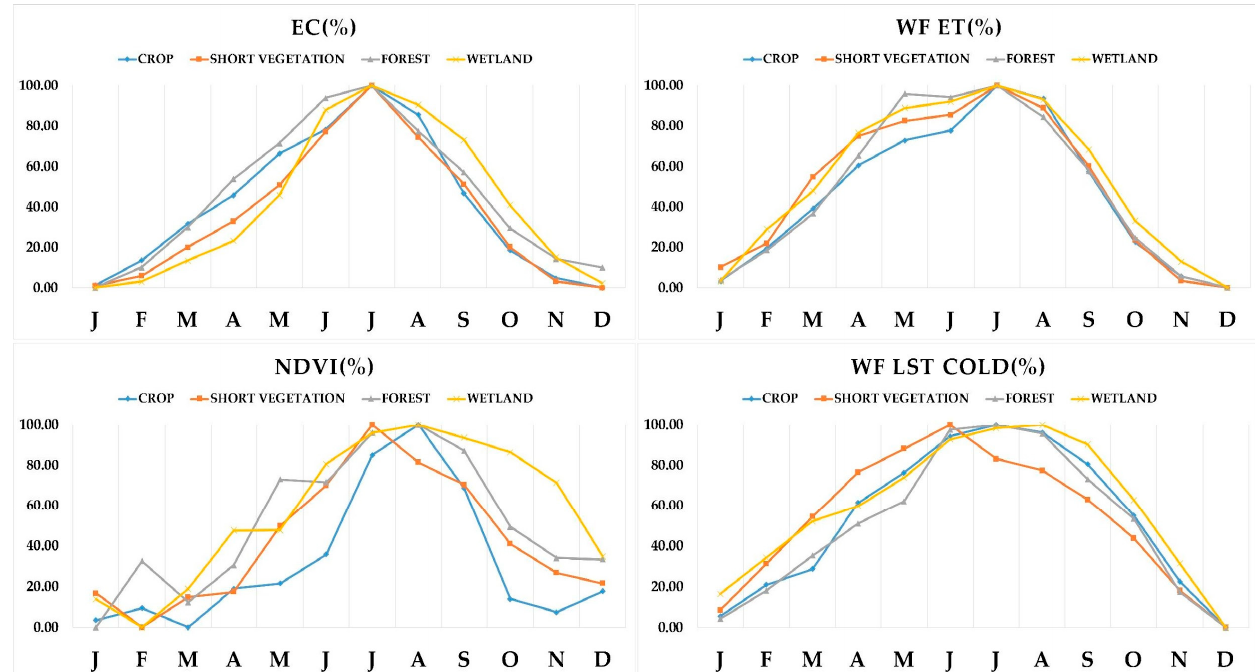
Figure 7. Monthly variation of ET and LST cold values obtained for WF, EC and NDVI at flux tower stations for each land cover. Note that the trend of NDVI at stations was the same as that for NDVI cold pixels.